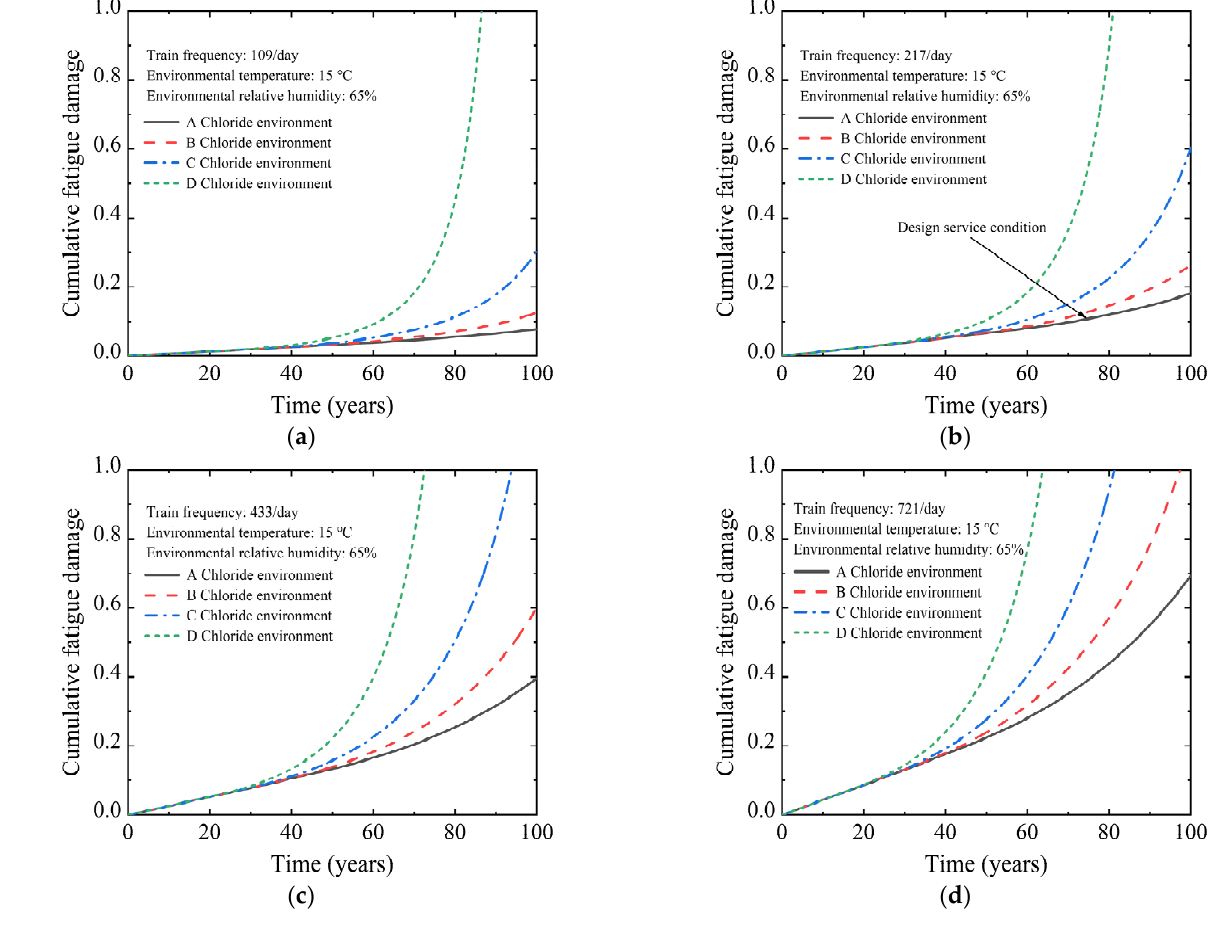
Figure 6. Cumulative fatigue damage of U-shaped beam under different train frequencies: ( a ) f = 107/day; ( b ) f = 214/day; ( c ) f = 433/day; ( d ) f = 721/day.